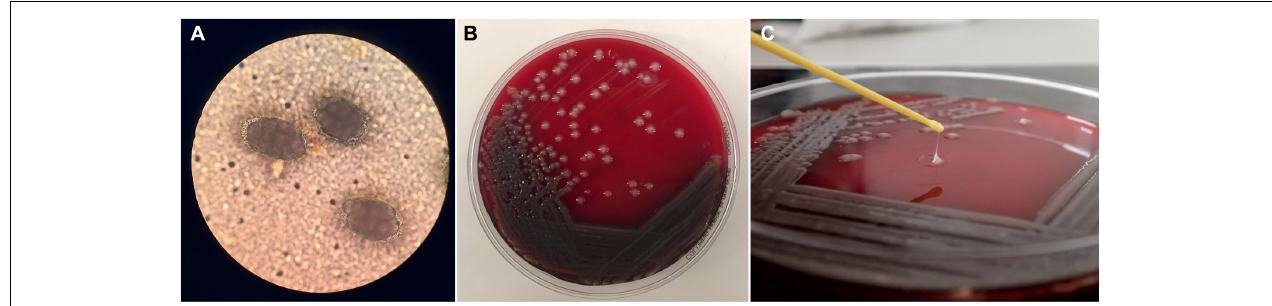
FIGURE 2 | Parasitology and microbiology analysis of samples collected from New Zealand sea lion ( Phocarctos hookeri ) pups on Enderby Island. (A) Hookworm ( Uncinaria spp.) eggs under light microscopy (20 × objective) on a direct fecal smear. (B) Pure culture of hypermucoviscous Klebsiella pneumoniae on horse blood agar plate showing large mucoid off-white to translucent colonies. (C) Positive string test on a hypermucoviscous K. pneumoniae isolate, determined by production of a viscous string > 5